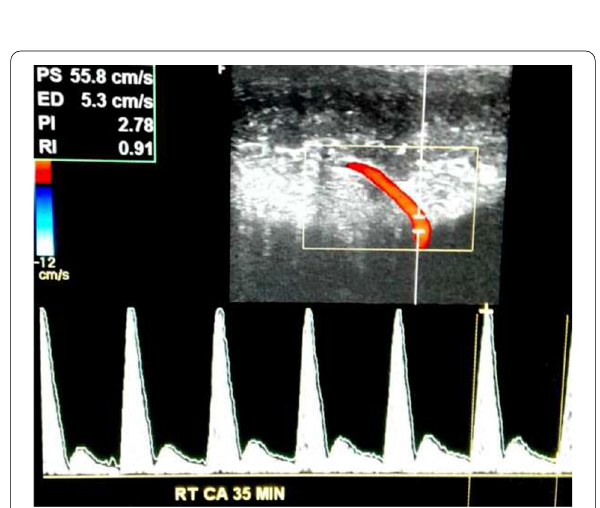
Fig. 5 Spectral waveform of the right cavernosal artery of a patient at 35 min showing normal arterial inflow with PSV of 55.8 cm/s, but the diastolic flow is persistent, features connoting venous leak (venogenic erectile dysfunction)